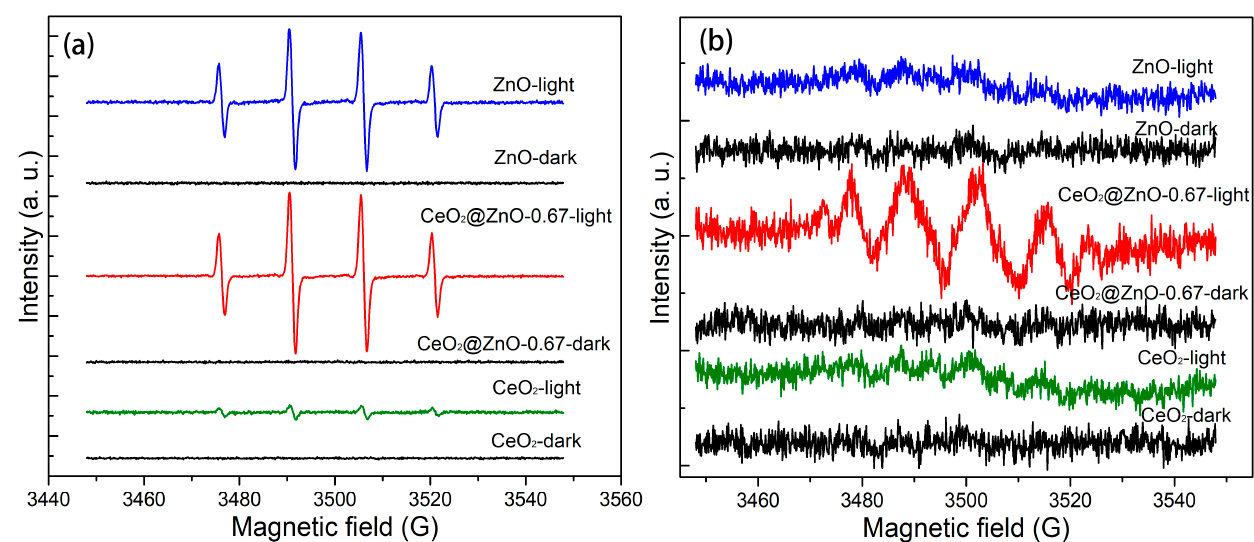
Figure 8. EPR spectra of the CeO 2 , ZnO, and CeO 2 @ZnO nanocomposites in the dark and under light irradiation: ( a ) DMPO-OH and ( b ) DMPO-O 2 − .